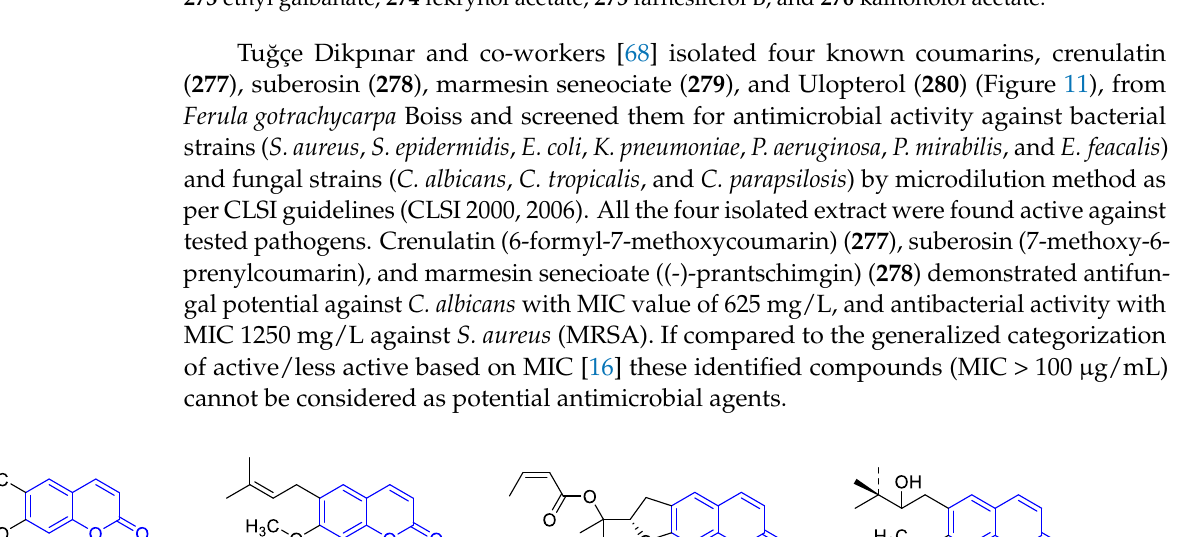
Figure 10 . Isolated coumarins from F. pseudalliacea roots 271 sanandajin, 272 methyl galbanate, 273